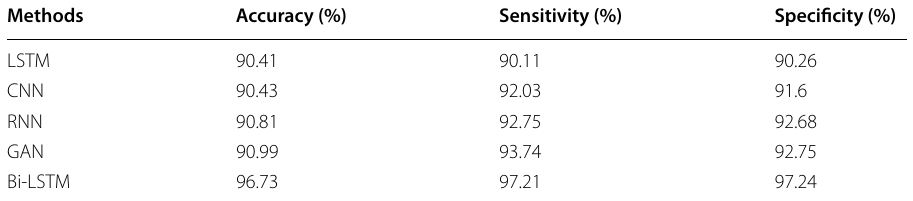
Table 6 Performance analysis of different deep learning methods for classification on NWPU dataset